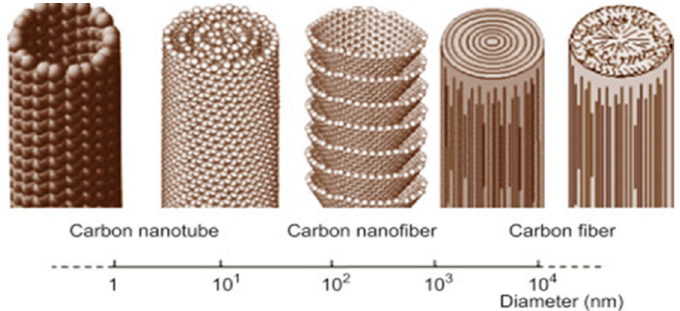
Figure 1. Morphology of 1D sp2 hybridized graphitic carbon allotropes and the relationship between fiber morphology and diameter inherent to the synthesis procedures [2].